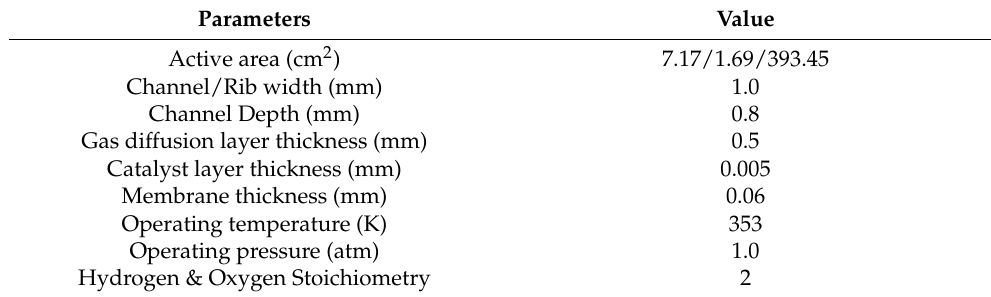
Table 1. Model Parameters.